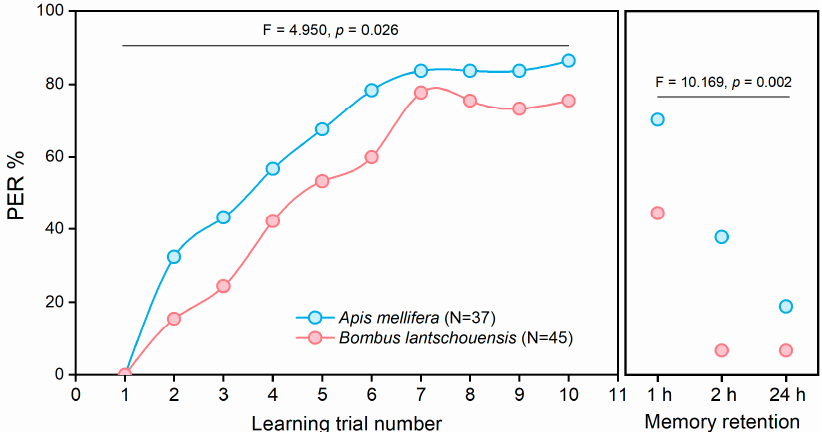
Figure 5. Proboscis extension responses (PERs) toward tomato floral scent in Apis mellifera and Bombus lantschouensis . Dots represent the proportions of bees showing a PER to tomato floral scent in each trial. The box on the right shows the memory retention of the bees 1, 2 or 24 h after training. Generalized linear mixed models were used to analyze the learning performance and memory retention of honeybees and bumblebees in response to tomato floral scent.